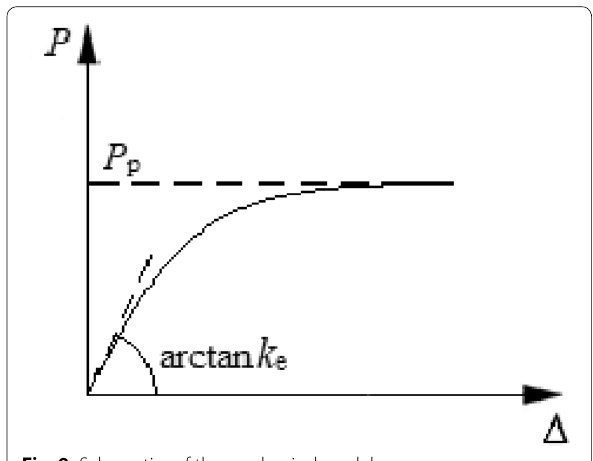
Fig. 9 Schematics of the mechanical model